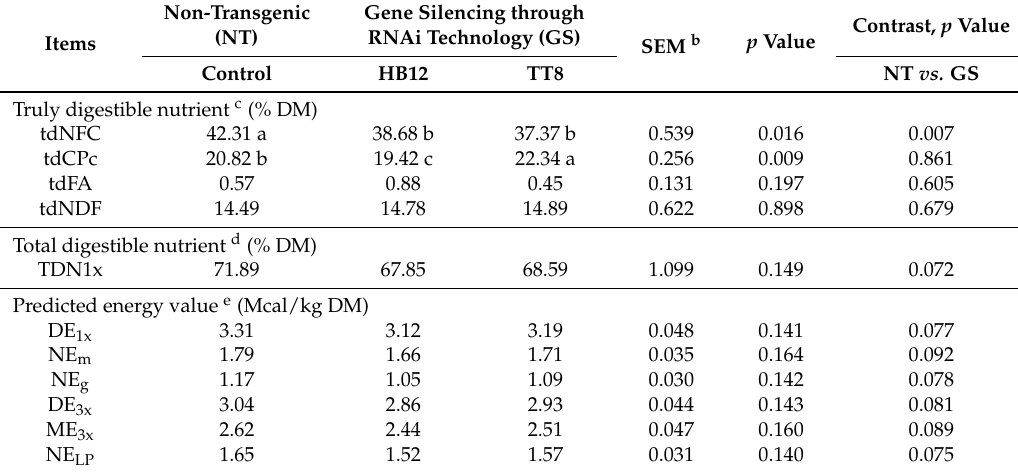
Table 1. Effect of HB12 and TT8 Down-regulation on Digestible Nutrient Profiles and Energy Values in Model Forage ( Medicago sativa spp. Sativa : Alfalfa) a